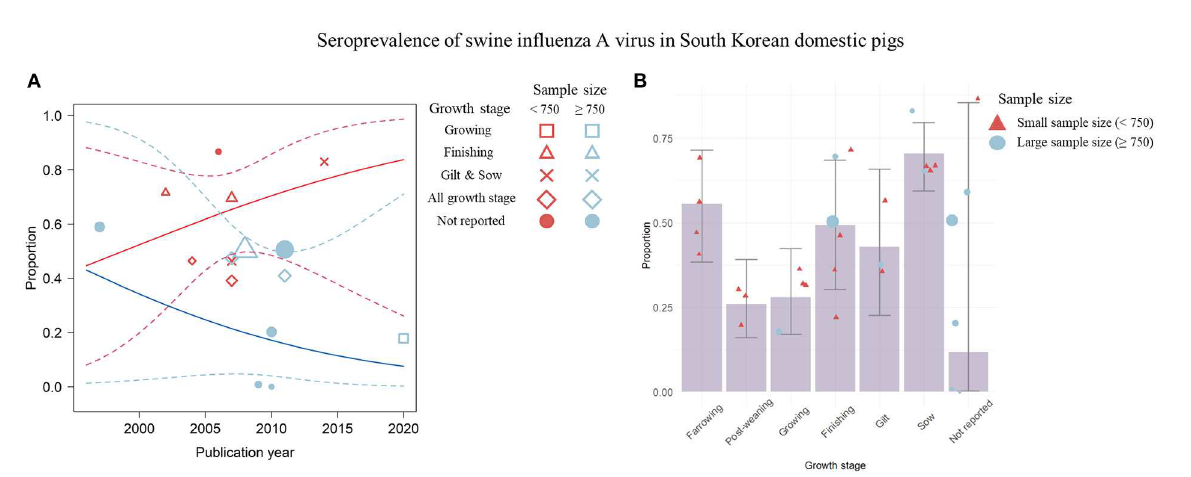
FIGURE6 Visualization of the seroprevalence data determined by the significant covariates; the publication year, the sample size, and the growth stage of pigs. (A) Change in swine influenza A virus (swIAV) seroprevalence according to the publication year shown by a weighted scatter plot. Solid red line denotes the regression model involved with the seroprevalence proportion, the small sample size, and the publication year. Solid blue line indicates regression describing the association among the proportion, the large sample size, and the publication year. The dashed lines indicate 95% CIs of the regression model. (B) swIAV seroprevalence by each growth stage using the bar plot. Circles or triangles indicate individual studies and the size of the figures corresponds to the weighted average of effect size of each study. The sample size is represented by red (small) and blue (large) colors. Error bar represents 95%